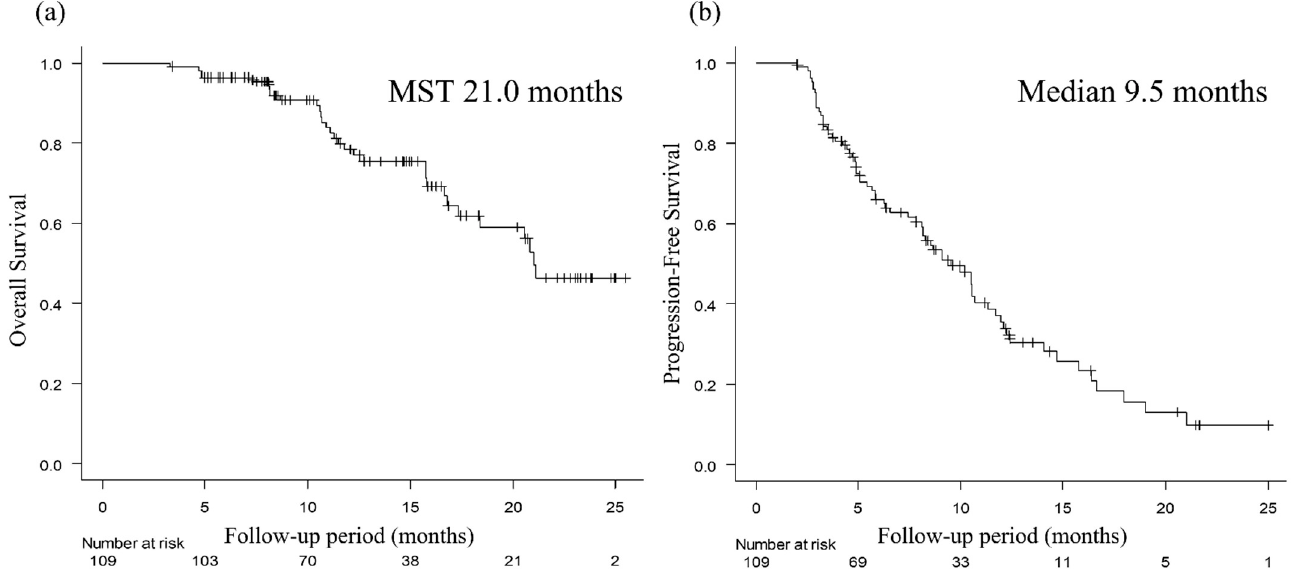
Figure 1. Overall survival (OS) and progression-free survival (PFS) from the initiation of atezolizumab plus bevacizumab (Atezo + Beva) in the 109 patients included in this study. ( a ) OS from the initiation of Atezo + Beva (median survival time (MST), 21.0 months). ( b ) PFS from the initiation of Atezo + Beva (median, 9.5 months).